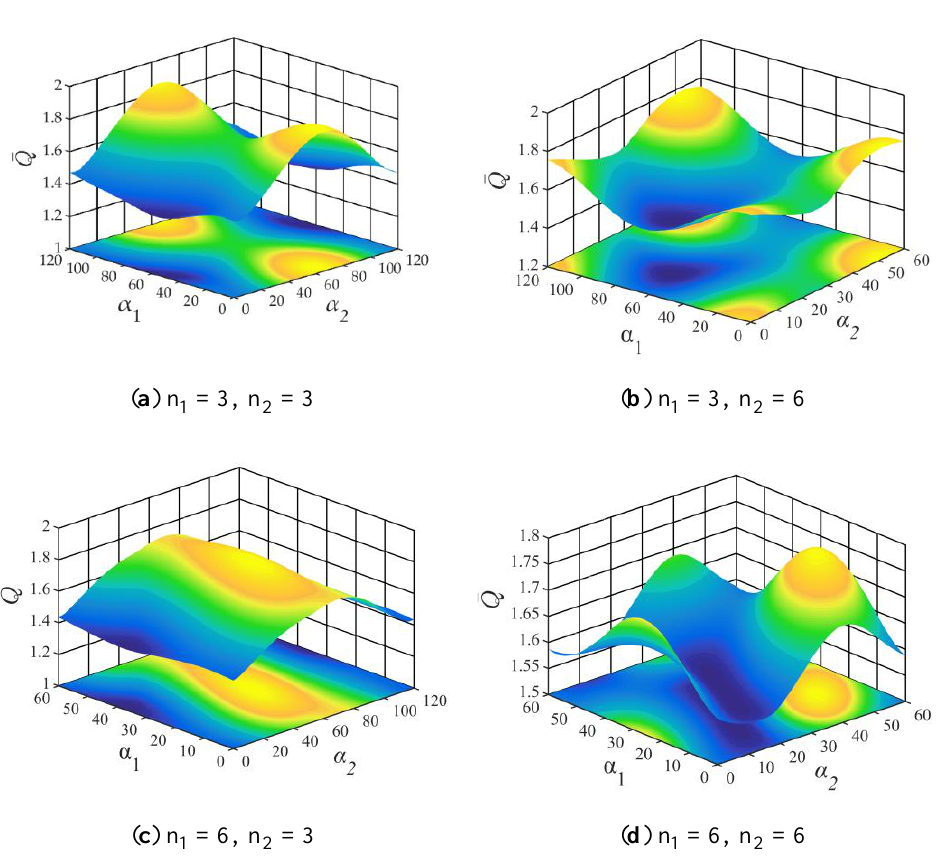
Figure 8. Variations of Q with the wave phase angle under four cases.